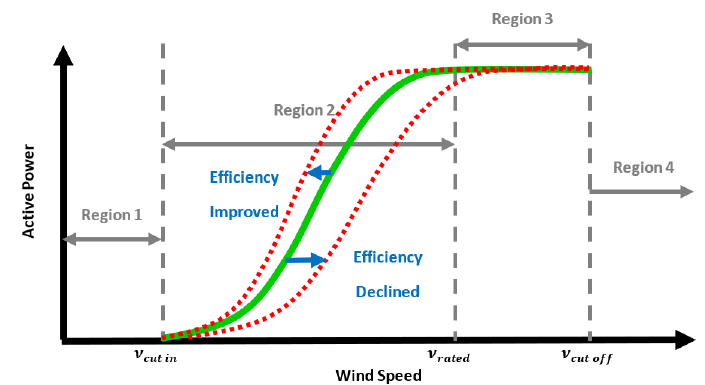
Figure 3. Wind turbine production